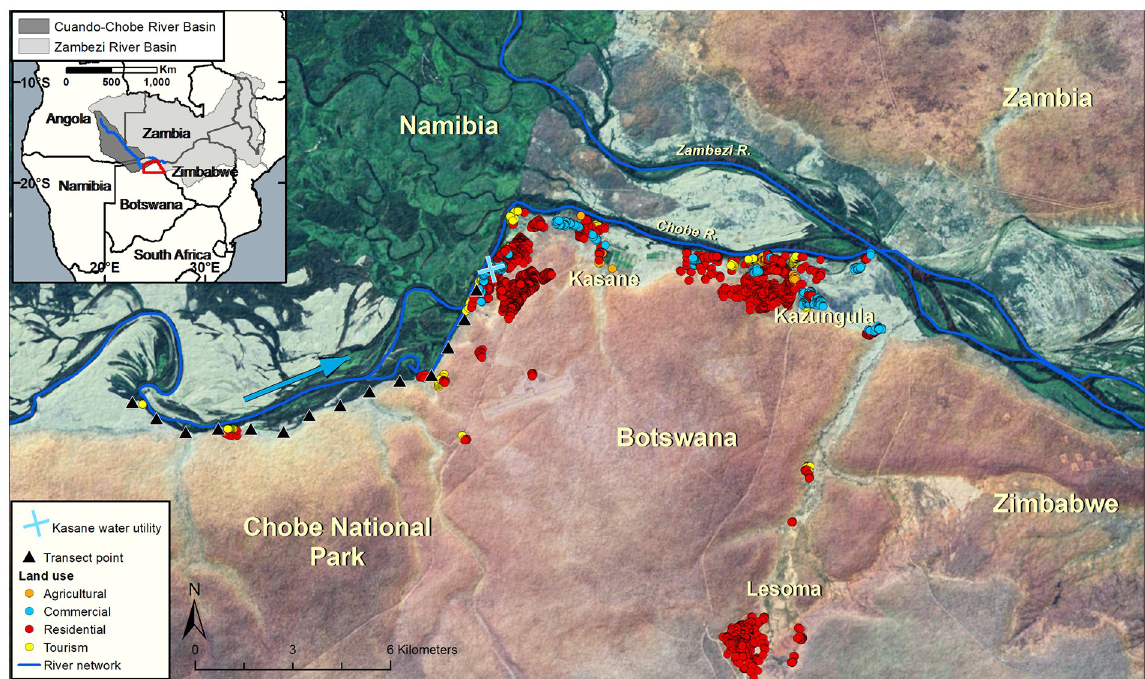
Fig 1. The study was conducted in northern Botswana in Southern Africa. The Chobe River (blue line) is a transboundary waterway and 1 of only 3 perennial sources of water within Botswana, with water flow (light blue arrow) moving from the national park towards the urban areas, where the water treatment facility is located (blue X). Water quality samples were collected biweekly at established transect points (black triangles). Surface waters are abstracted to produce drinking water through centralized water treatment facilities and distributed to the population. Circles represent buildings color coded by the type of infrastructure (agricultural, commercial, residential, or tourism related; see legend). In this system, annual floods are driven by distant and regional wet season precipitation, with the largest input arising from floodwaters that occur in association with tropical rains in the upper watersheds of the Zambian and Angolan Highlands (inset, northern aspect of the Cuando-Chobe River Basin). The peak of the flood pulse arrives in the Chobe River at the end of the wet season/beginning of the dry season, after traversing more than 1,000 km from the highland